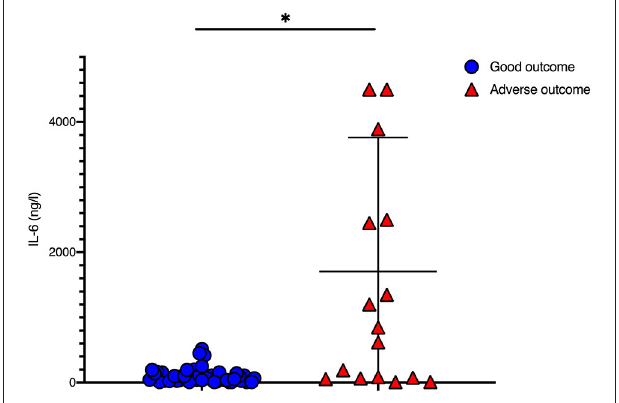
FIGURE 1 | IL-6 values before initiation of therapeutic hypothermia: IL-6 values were significantly higher in newborns with death or adverse MRI findings, defined as BG/W score > 2. Data presented as mean ± standard deviation (SD), * p <